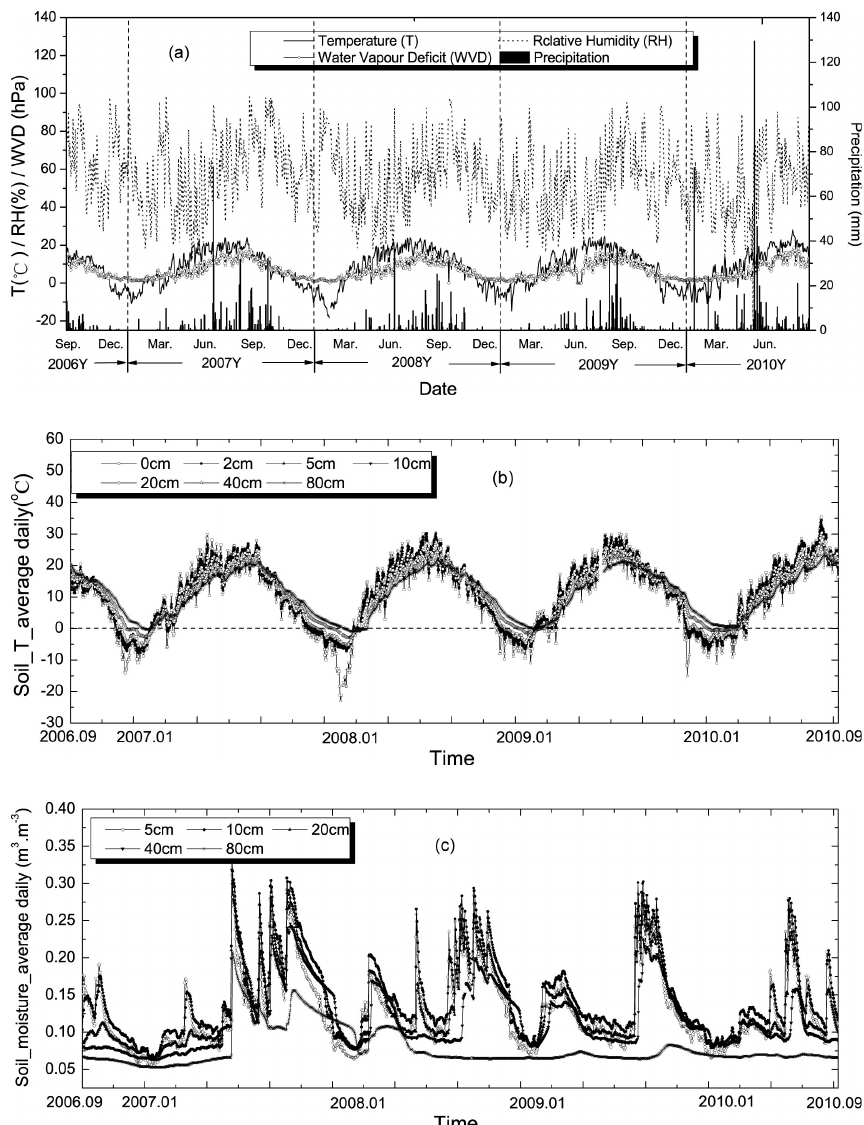
Fig. 5. Yearly variation of the daily means of several meteorological and hydrological variables over the native grassland of the semi-arid loess plateau: (a) temperature, relative humidity, water vapour deficit and precipitation; (b) soil temperature; (c) soil moisture.